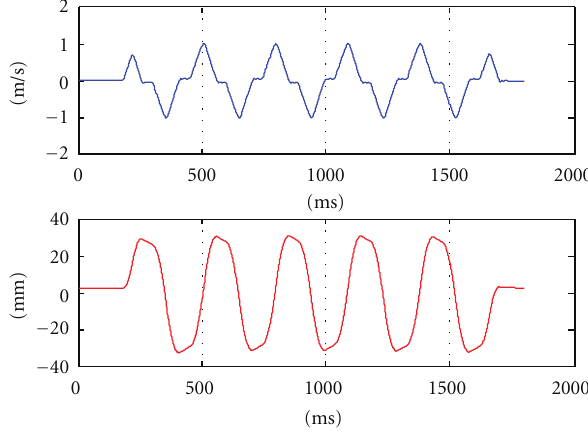
Figure 14: Sample horizontal velocities and displacements of the robot end e ff ector measured at a grid point of the workspace.